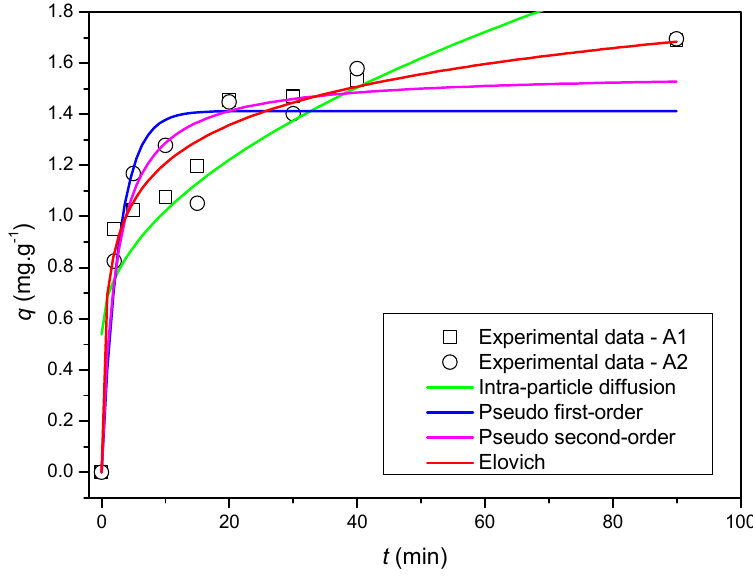
Figure 6. Kinetic models fitted to experimental data for AC.